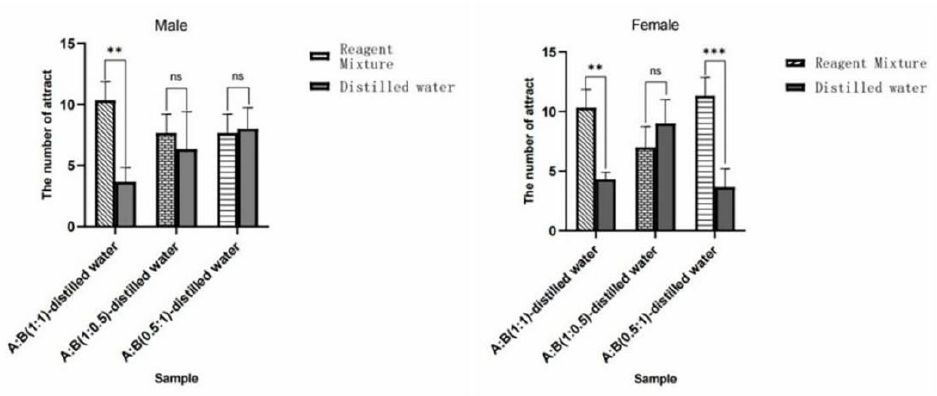
Figure 36. Behavioral responses of W. magnifica by mixing methylheptenone and 1-octen-3-ol in dif-